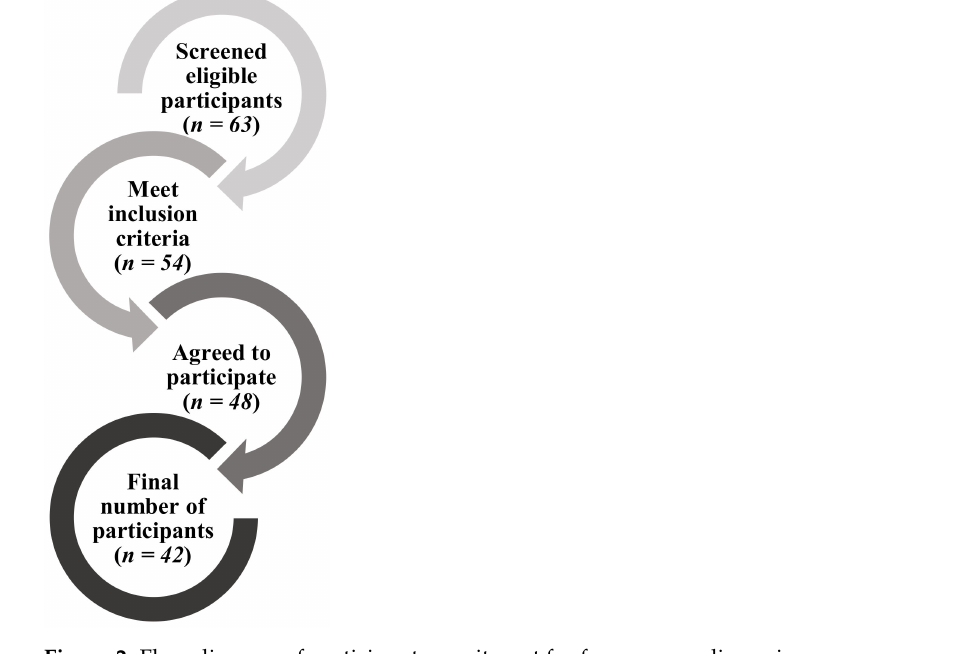
Figure 2. Flow diagram of participant recruitment for focus group